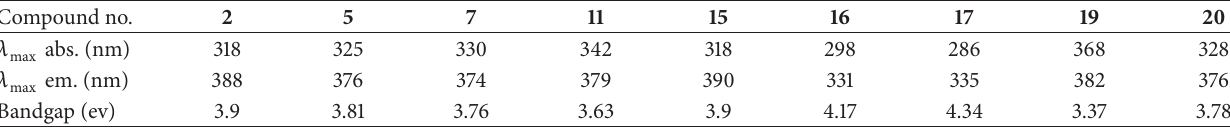
Table 1: Optical properties of the products 2 , 5 , 7 , 11 , 15 , 16 , 17 , 19 , and 20